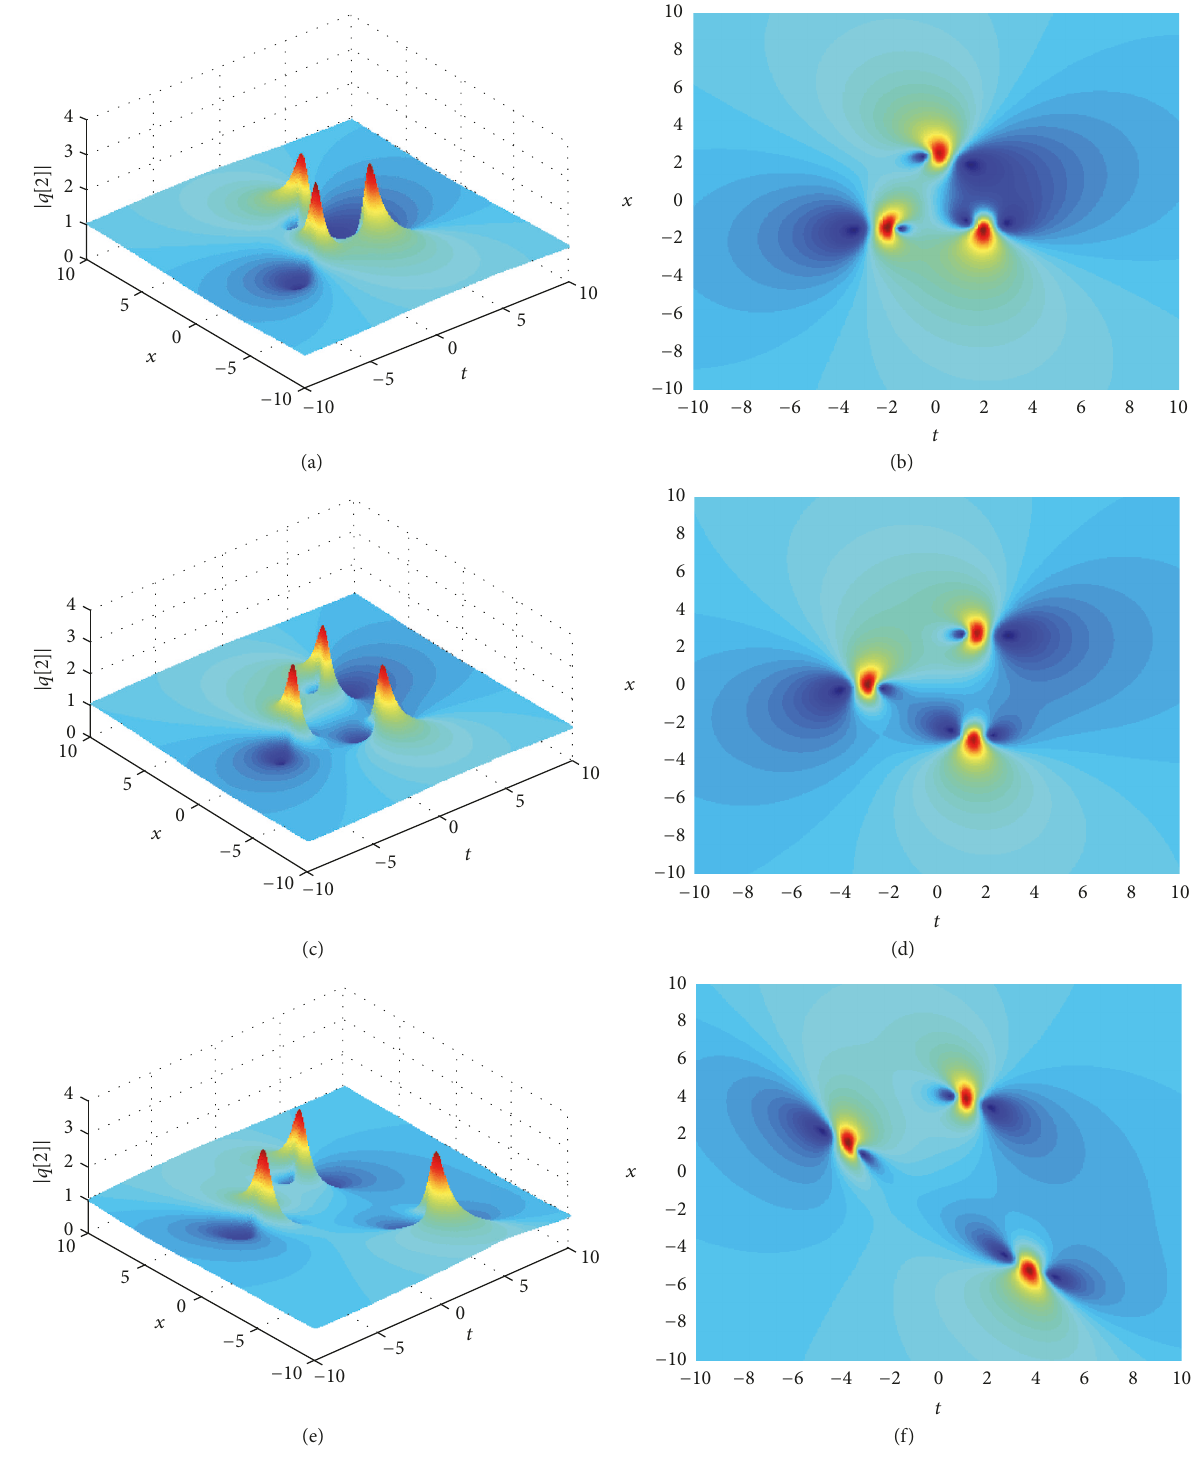
Figure 3: (a) The second-order rogue wave with 𝜀 = 0 , 𝑎 1 = 10 , and 𝑏 1 = 0 ; (b) the density plot with 𝜀 = 0 , 𝑎 1 = 10 , and 𝑏 1 = 0 ; (c) the second-order rogue wave with 𝜀 = 0 , 𝑎 1 = 0 , and 𝑏 1 = 20 ; (d) the density plot with 𝜀 = 0 , 𝑎 1 = 0 , and 𝑏 1 = 20 ; (e) the second-order rogue wave with 𝜀 = 0.1 and 𝑎 1 = 𝑏 1 = 40 ; (f) the density plot with 𝜀 = 0.1 and 𝑎 1 = 𝑏 1 = 40